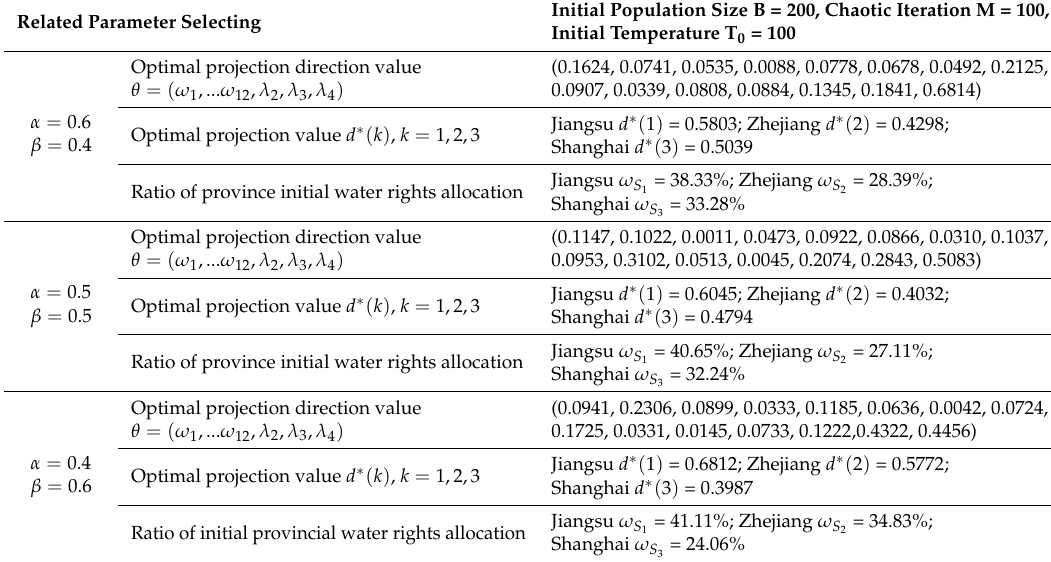
Table 3. Results of initial provincial water rights allocation in Taihu Basin. Related Parameter Selecting